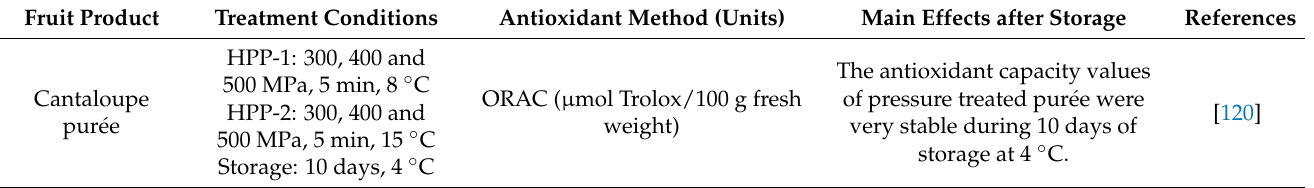
Table 1. Effect of HPP treatment and storage on the antioxidant capacity of fruit pur é es and pulp. Fruit Product Treatment